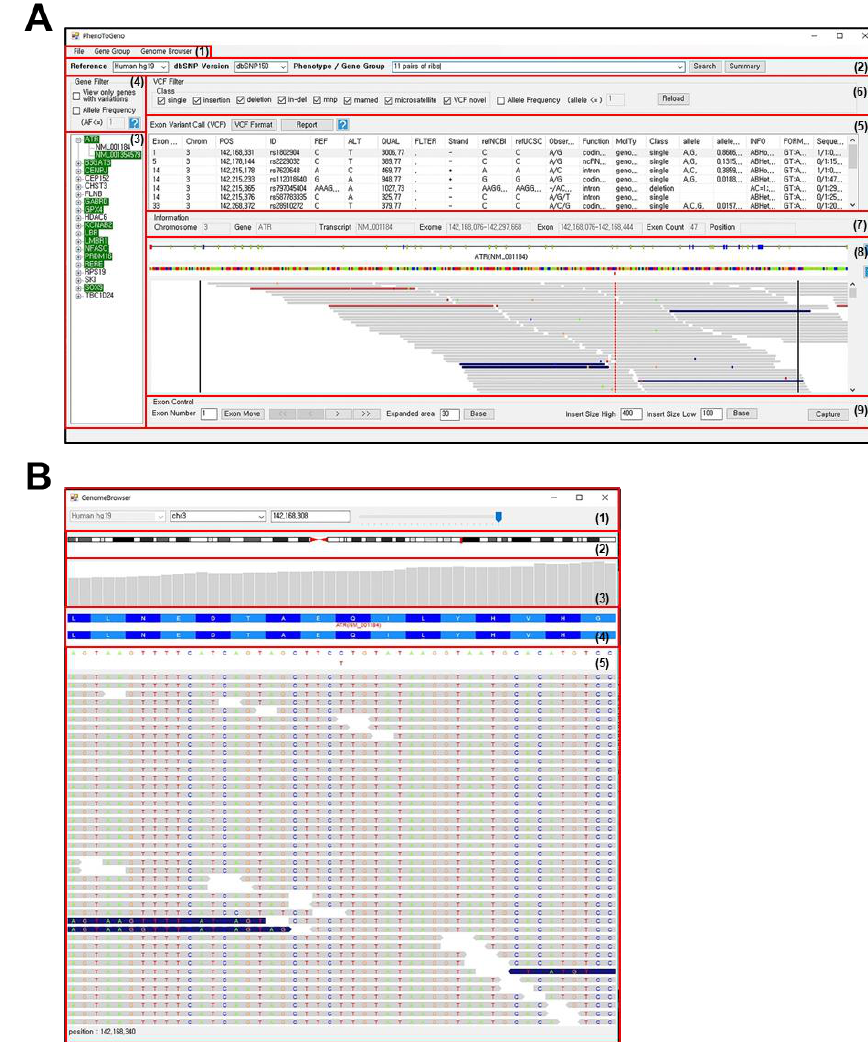
Figure 1. Main pages of PhenGenVar exome and genome browser. ( A ) Main page of PhenGenVar exome browser. The browser consists of menu bar (1), control panel (2), gene/transcript view panel (3), gene filter panel (4), exon variant call panel (5), VCF filter panel (6), information panel (7), main exon view panel (8), and exon view control panel (9). ( B ) Main page of PhenGenVar genome browser. The browser consists of control panel (1), cytoband panel (2), coverage graph panel (3), genetic structure panel (4), and main genome view panel (5).